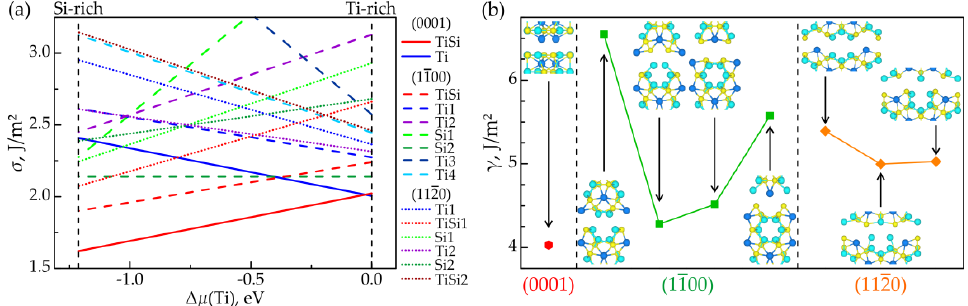
Figure 3. Dependence of surface energies of low-index surfaces of Ti 5 Si 3 on the chemical potential of titanium ( a ); cleavage energy (in J/m 2 ) for corresponding planes shown by solid lines ( b ).